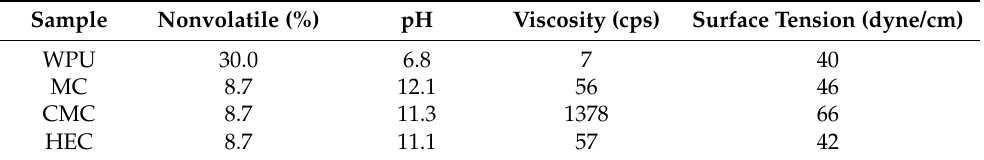
Table 2. Properties of WPU dispersion and cellulose